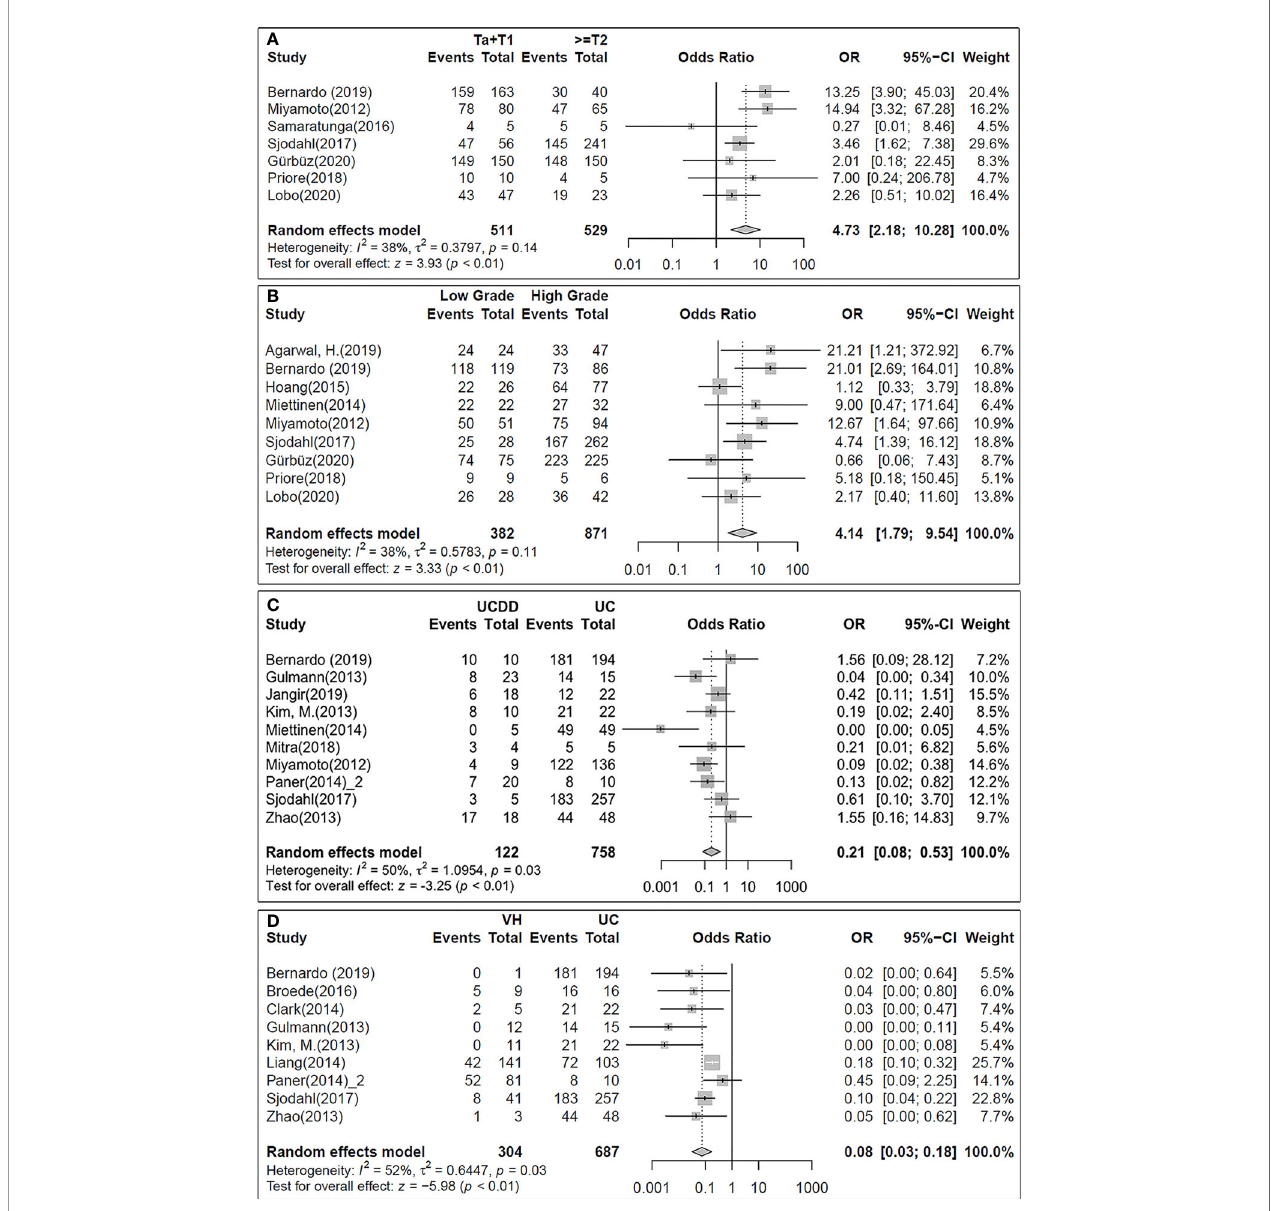
FIGURE 6 | Forest plots for the binary meta-analysis showing the association between GATA3 positivity and the clinicopathological parameters tumour stage (A) , tumour grade (B) and histological differentiation of the tumours (C, D)